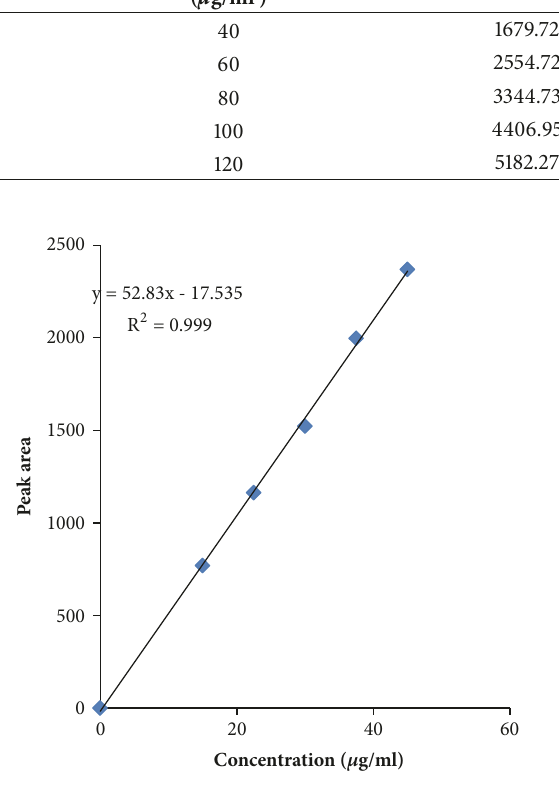
Figure 7: Calibration curve of levamisole.